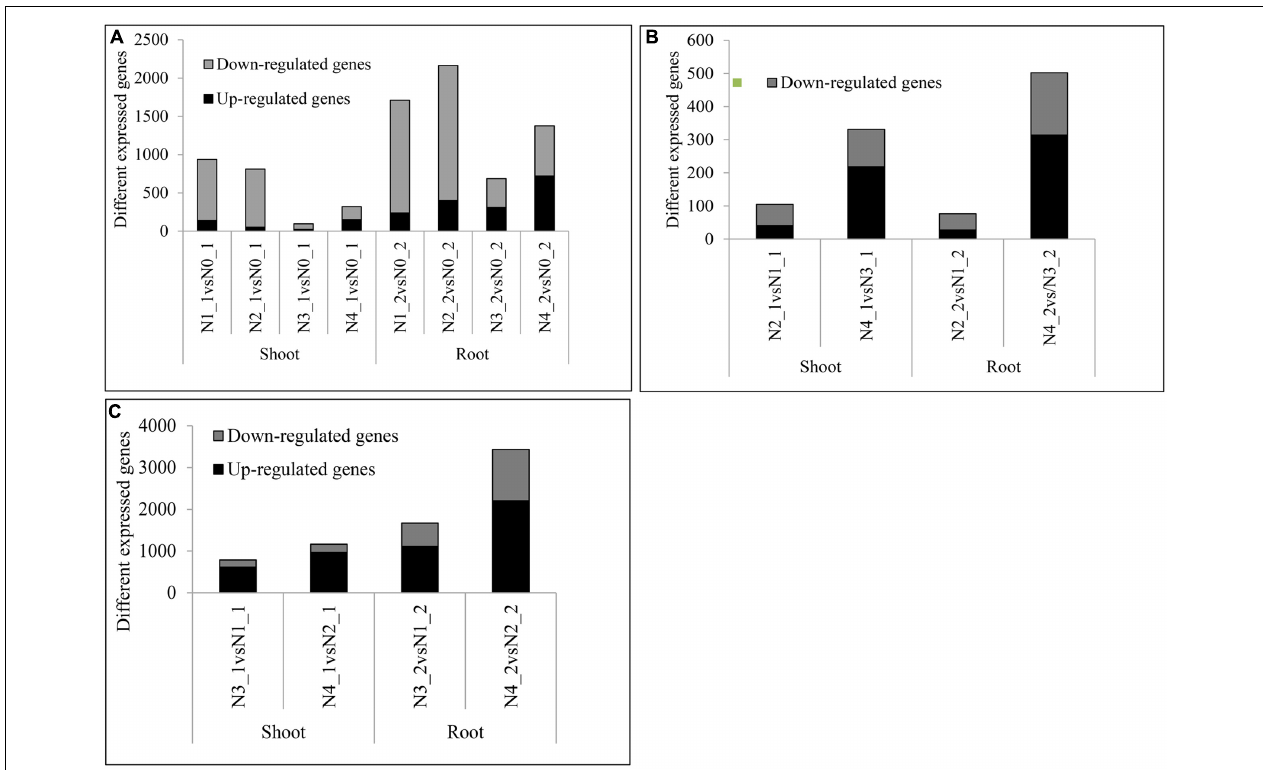
FIGURE 5 | Summaries of differentially expressed genes (DEGs) at salinity and GR24 treatments. DEGs were identified by comparing each treatment to N0 (A) , DEGs under salinity stress (B) , and DEGs under GR24 treatment (C) . The “N1_1 vs N0_1” indicates a comparison between the gene expression in the N1_1 library with that in the N0_1 library, and the same describes the other labels on the x -axis. DEGs were confirmed based on whether the |log 2 FPKM ratio| ≥ 1 and P -value ≤